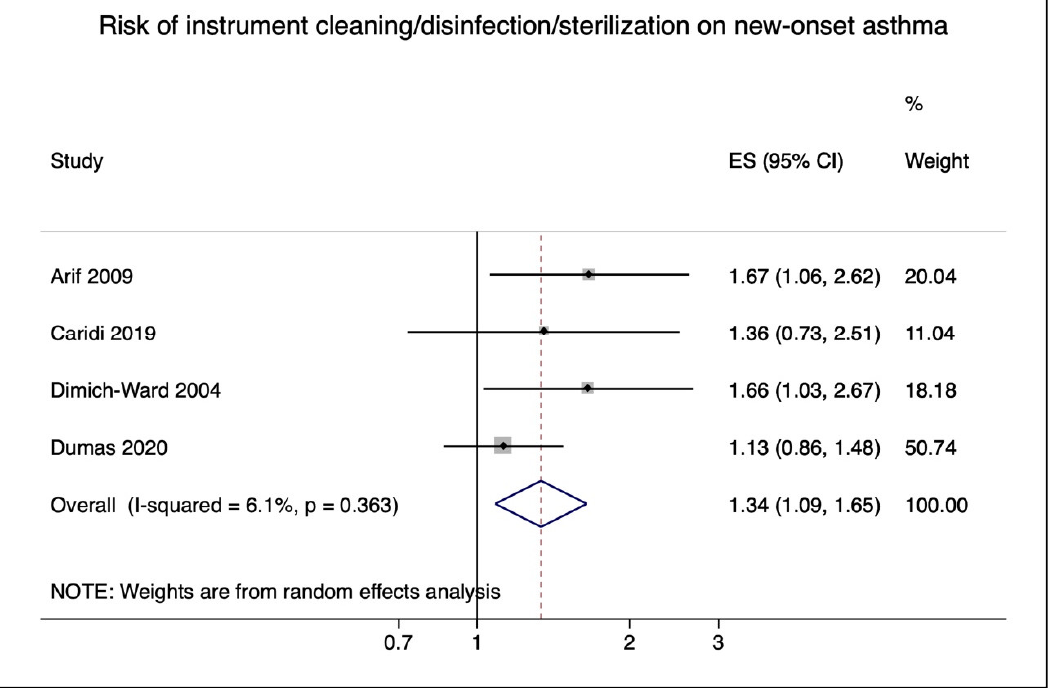
Figure 6. Risk of exposure to bleach on asthma (WRAS, work-related asthma symptoms, NOA, new-onset asthma).